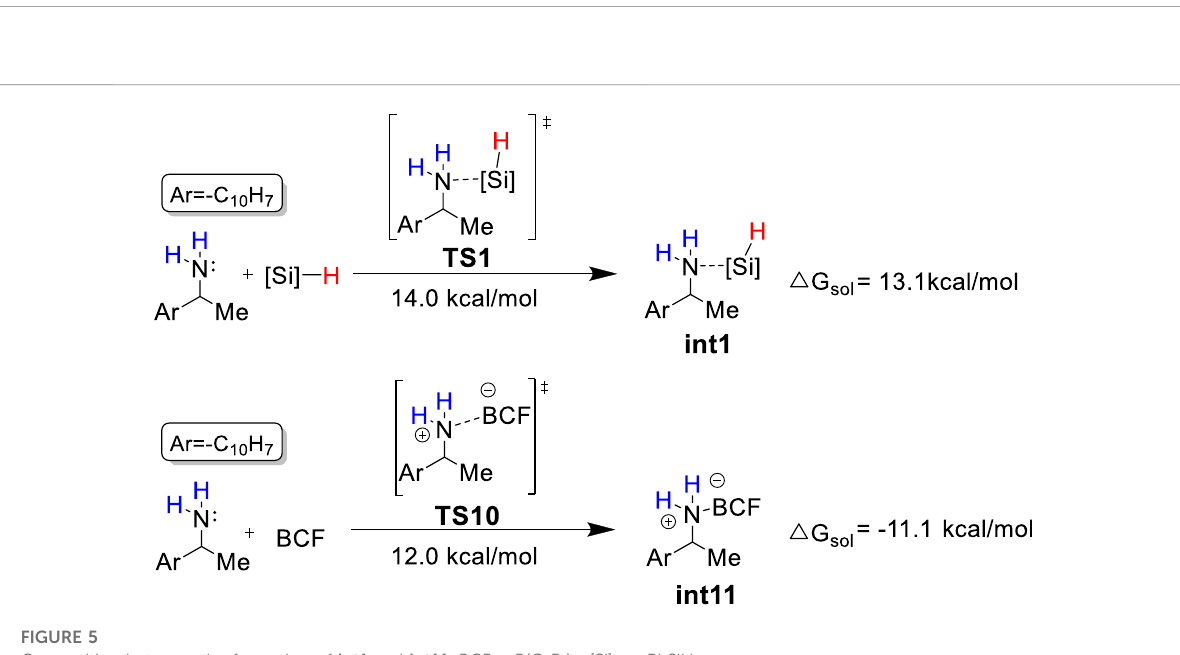
Top: Overlapping troughs in s( ρ ) plots can be distinguished when sign ( λ 2 ) ρ is used as the ordinate. Favorable interactions appear on the left, unfavorable on the right, and van der Waals near zero; Medium: NCI surfaces of TS3 , TS4 , TS6 and TS7 correspond to s = 0.5 au and a colour scale of − 0.05 < ρ < 0.05 au for SCF densities; Bottom: structures of TS3 , TS4 , TS6 and TS7 (Non-reacting hydrogen atoms are omitted for clarity).